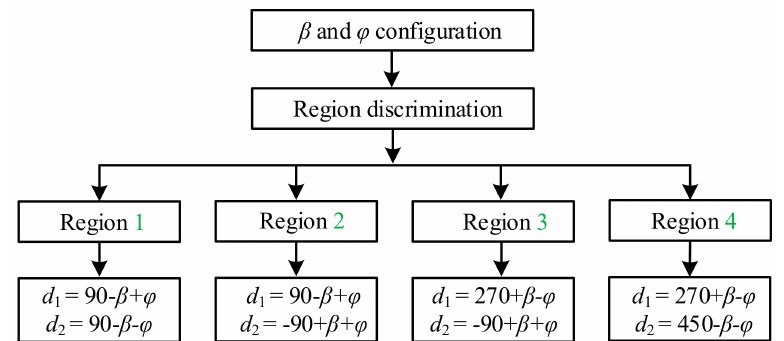
Figure 8. Calculation of d 1 and d 2 .